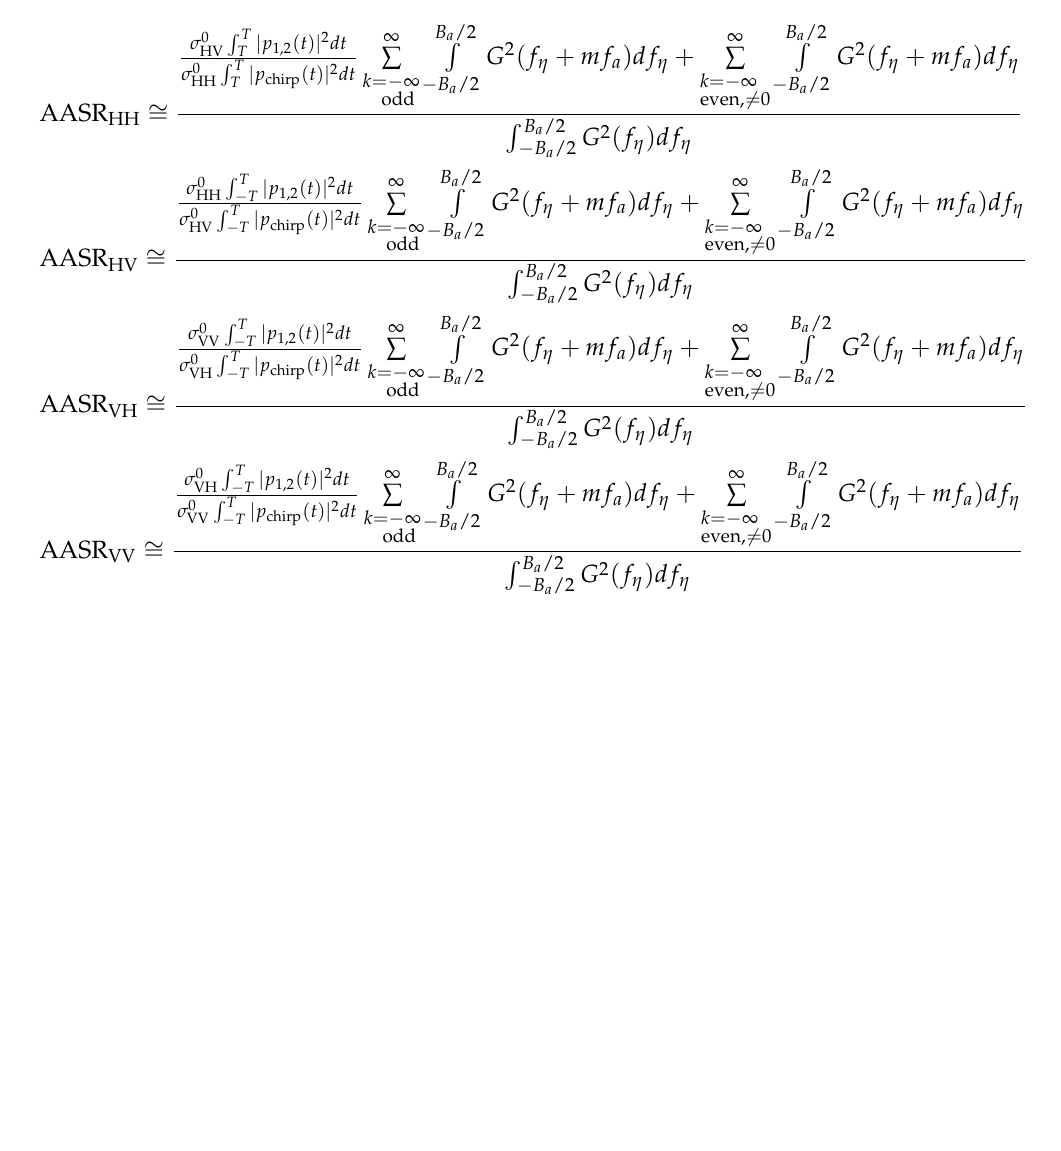
Figure 3. Timing diagram for a conventional quad-pol SAR system with waveform diversity. Next, for the hybrid quad-pol SAR system with waveform diversity (the timing diagram is shown in Figure 4), the revised AASR equations are given by (the conventional AASR equations are given in Equation (45) of